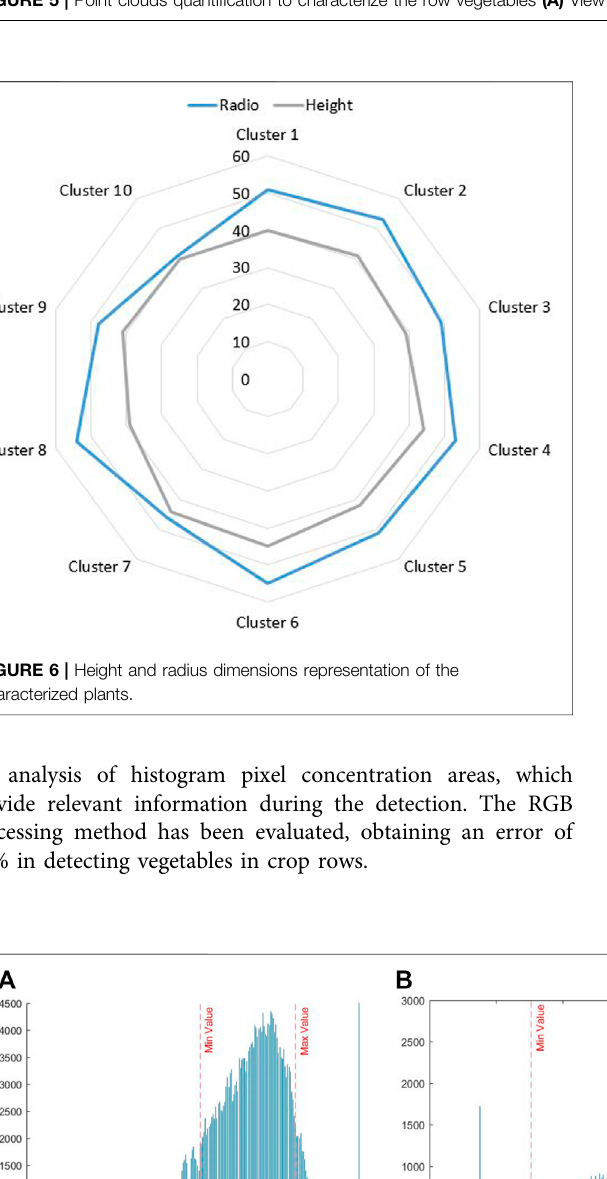
Frontiers in Robotics and AI |